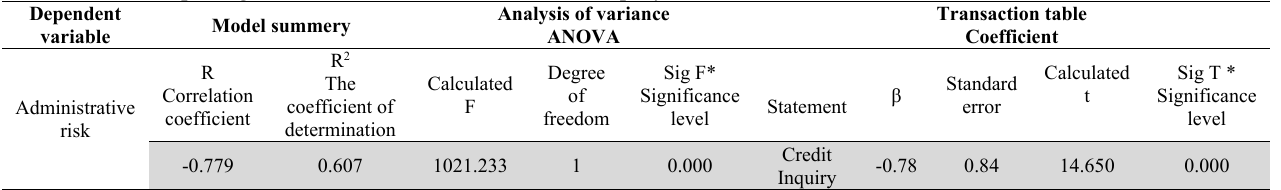
Results of the simple regression test for the effect of credit inquiry on administrative credit risks Dependent Model variable